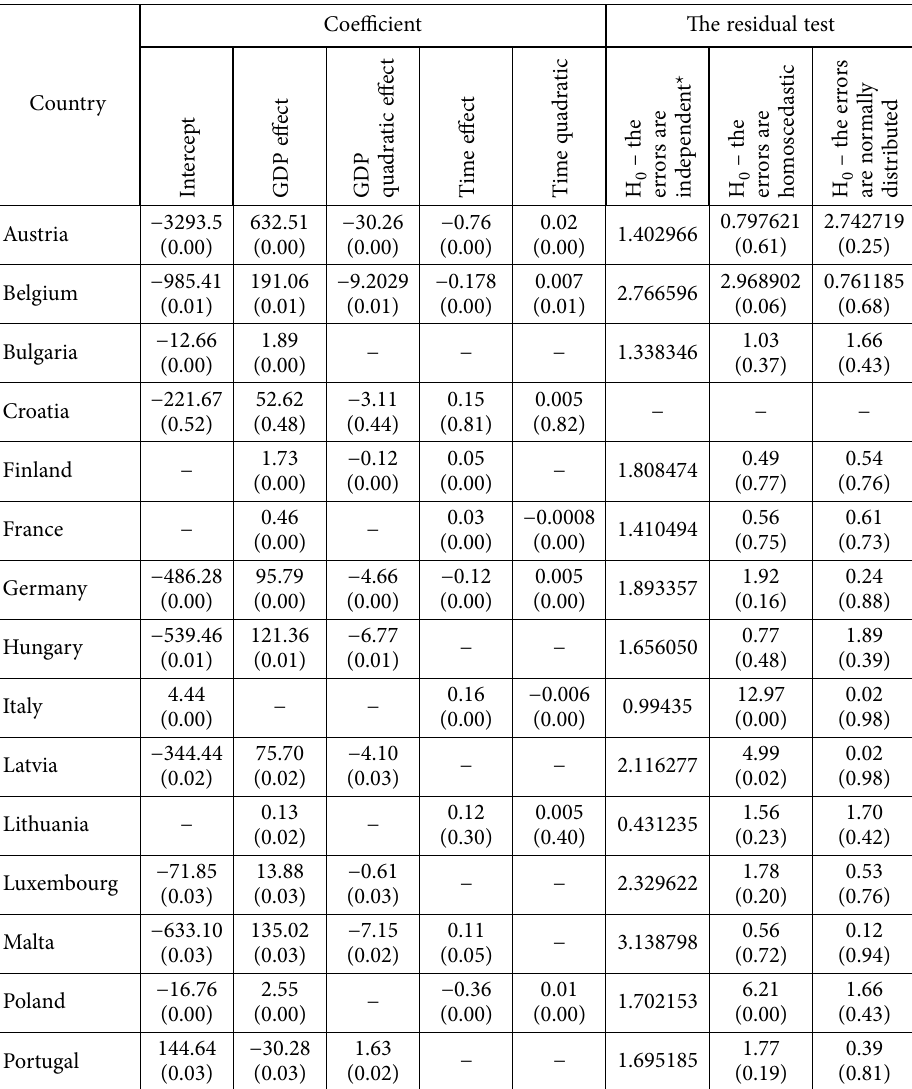
Table 3. OLS regression results – Dependent variable: Central Government Environmental Protection Expenditure